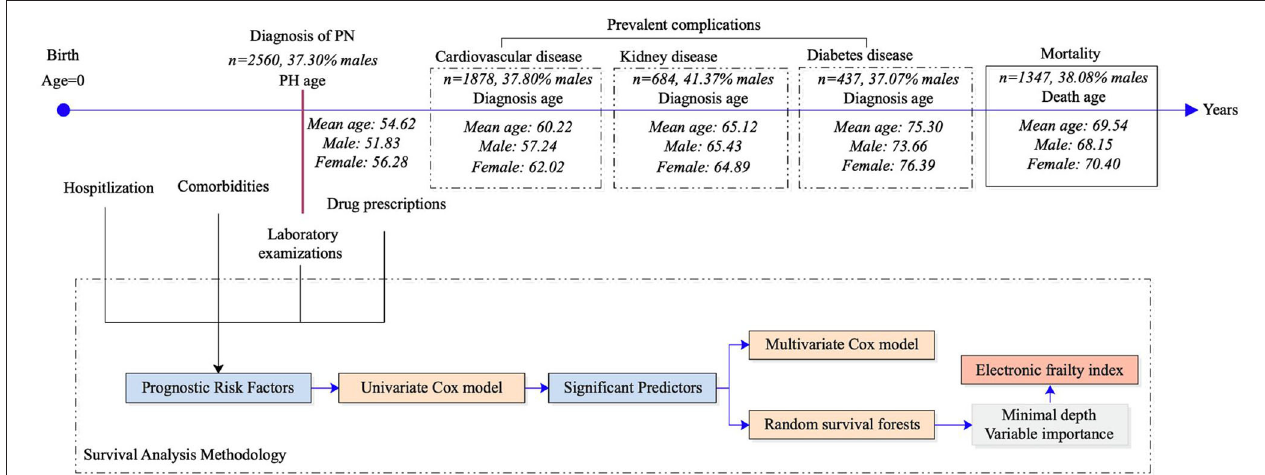
FIGURE 1 | Illustration of the study procedures. PN, Pulmonary